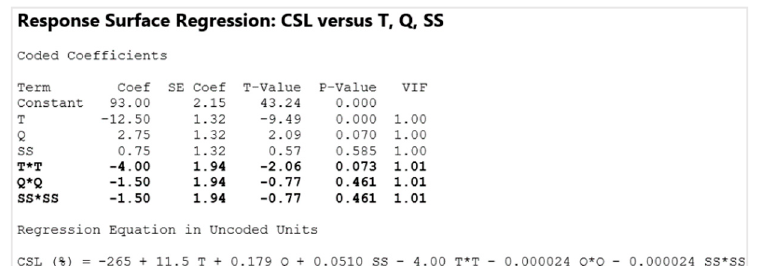
Figure 18. BBD—response surface regression of CSL (%) versus T, Q, and SS. After excluded these terms, the BBD experiment was run again, the reduced model is shown in Figure 19. The results show that only the term Q, SS, and the square term T*T ( p -values were 0.054, 0.564, and 0.067, respectively) were slightly significant because the p -value was slightly out of the confidence level at 95%. Otherwise, only the terms T was highly significant to the BBD experiment ( p -value < 0.05).